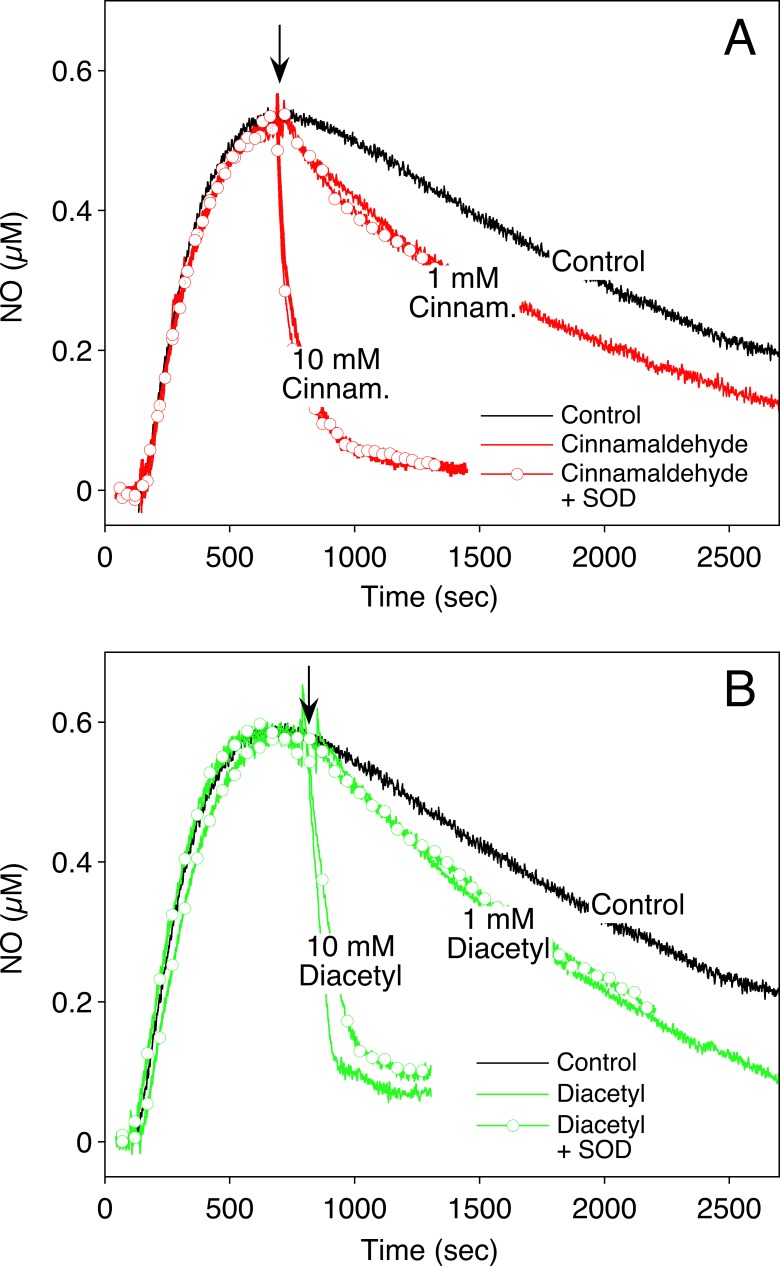
Inactivation of NO by cinnamaldehyde (A) and diacetyl (B). NO formation was induced by adding DEA/NO (final concentration 1 μM) to 100 mM phosphate buffer, pH 7.4. At time points indicated by arrows, cinnamaldehyde or diacetyl was added. Experiments performed in the presence of SOD (2500 U/ml) are marked with open circles. Original traces each representative for 3 experiments are shown.